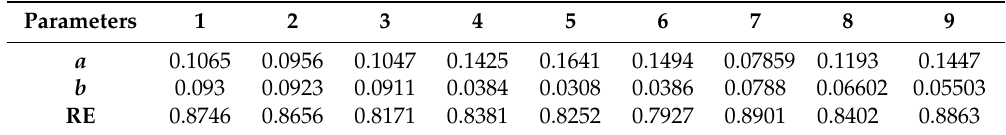
Table 3. Estimated parameters of Logarithmic distribution.